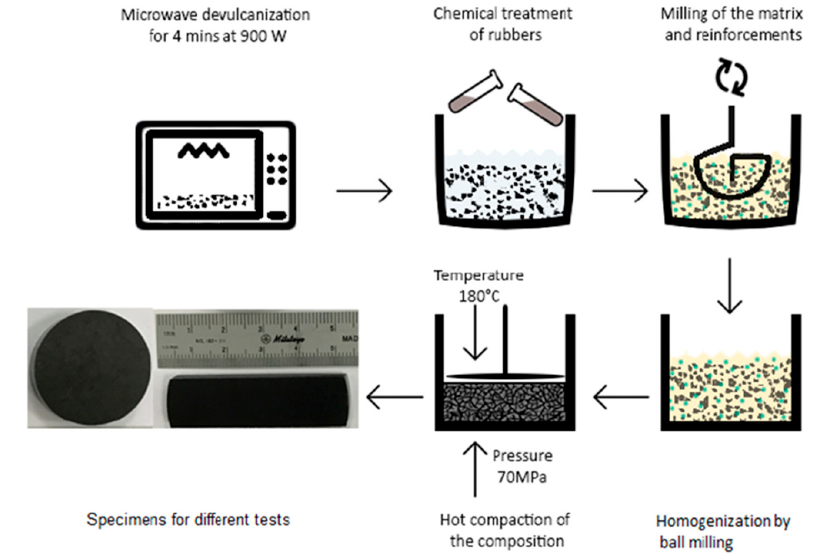
Figure 2. Manufacturing steps of liquid epoxy-based recycled EPDM-modified composites.